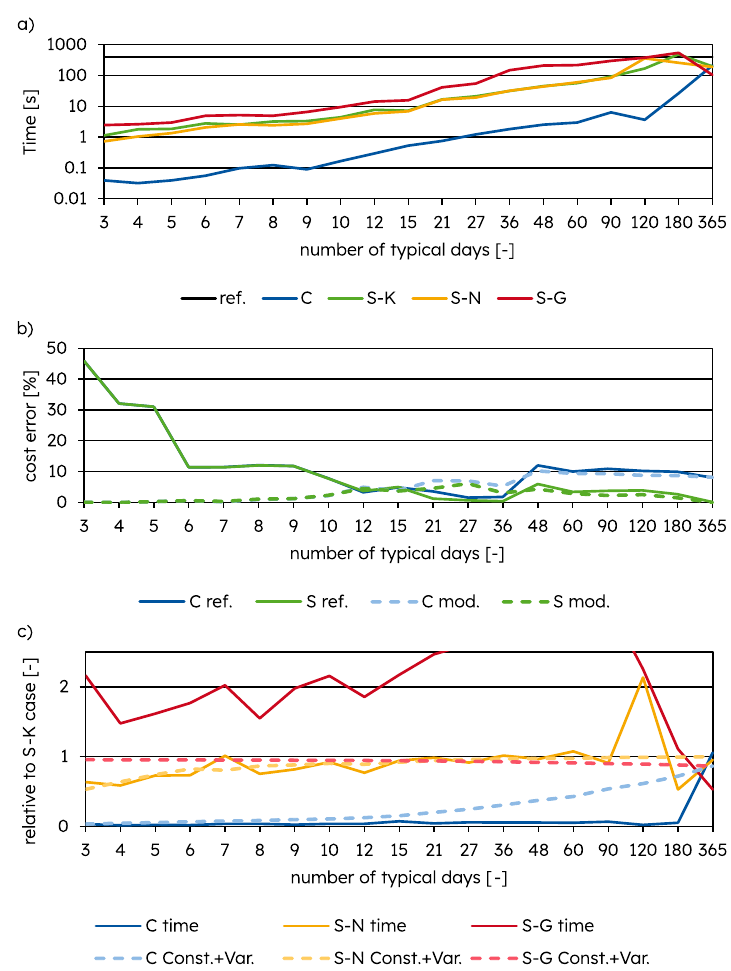
Fig. 5 Calculation time ( a ) and total costs error ( b ) for the different storage models and relative share of number of constraints and variables as well as time for C, S-G- and S-N- to S-K-model ( c ) for Island